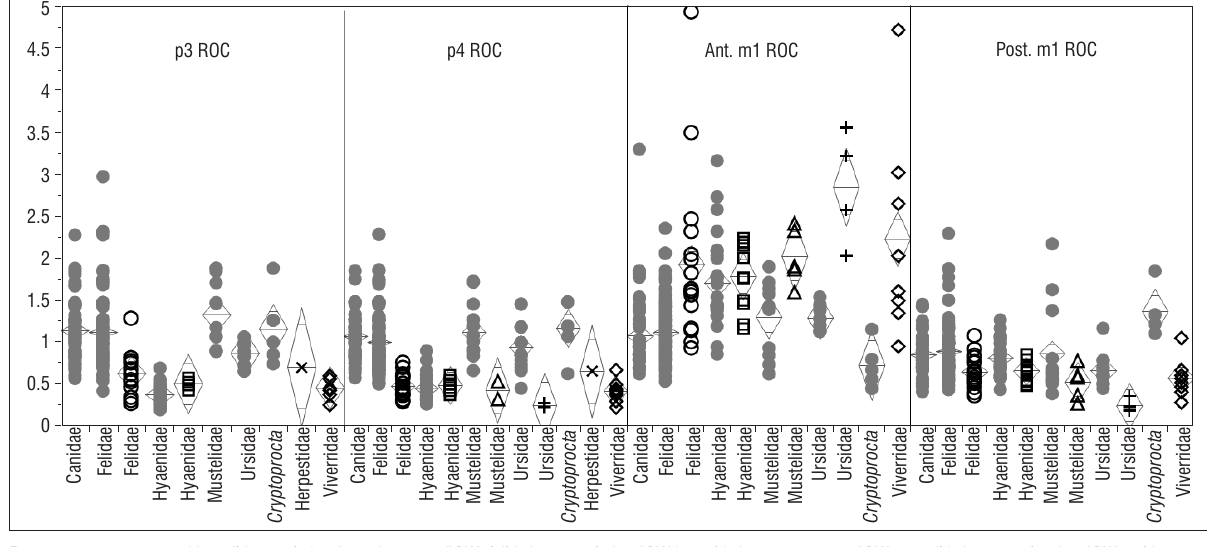
Although the LBW ursids ( Agriotherium ) and mustelids do not preserve third premolars that are complete enough for ROC analysis, the p4 ROC results are interesting; in the ursid comparison, the Agriotherium specimens have significantly less-sharp premolars than their modern confamilials ( p =0.0048), and while there are only two LBW mustelids with well-preserved fourth premolars, these two teeth are less-sharp than those of their modern confamilials, and despite the small sample, this difference does approach significance ( p =0.0567). Similar patterns exist when considering the sharpness of the posterior cusp (protoconid) of the carnassial; the LBW felids and viverrids have significantly less sharp posterior carnassial cusps than do modern felids and Cryptoprocta ( p =0.0239 and p <0.0001, respectively). The fossil mustelids and ursids have duller posterior carnassial cusps than do their modern confamilials, although these differences are not significant at these small sample